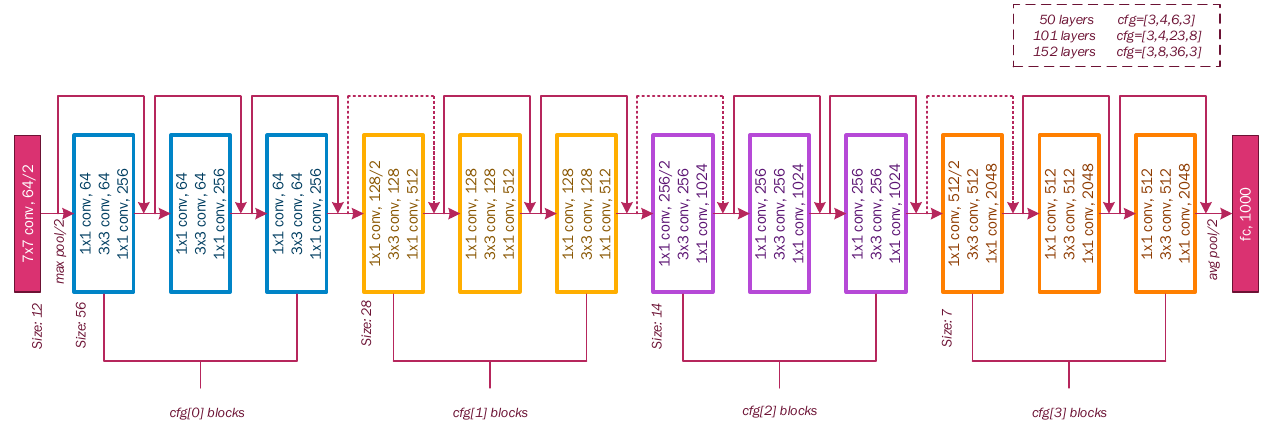
Figure 6. Configuration of residual network architecture, including ResNet-50, ResNet-101, and ResNet-152.